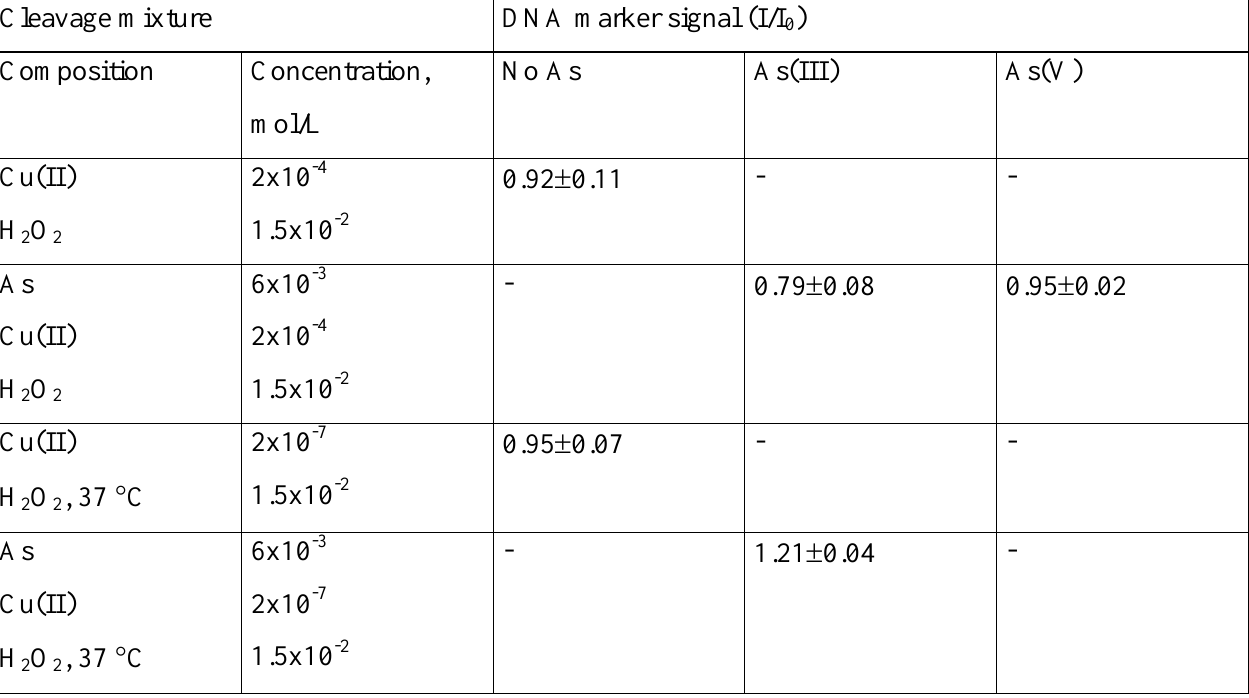
Table 2. Effect of inorganic arsenic on DNA at 10 min incubation of DNA/SPE sensor in cleavage mixtures with Cu(II) ions at 22 ° C (not indicated) and 37 ° C. Conditions: 1x10 -2 mol/L phosphate buffer solution pH 7.0 under